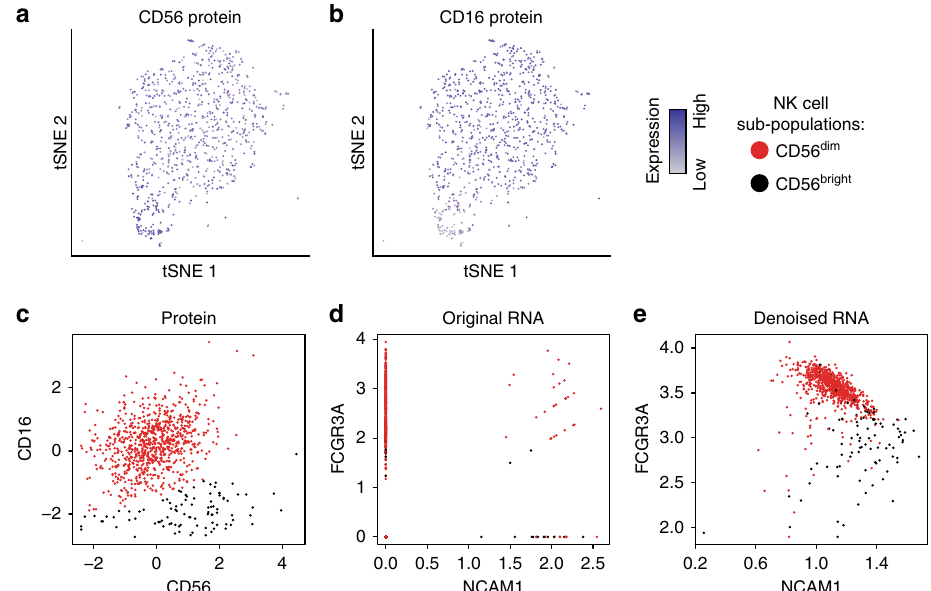
Fig. 8 Denoising enhances discovery of cellular phenotypes. tSNE visualization of transcriptomically derived NK cell cluster colored by CD56 ( a ) and CD16 ( b ) protein expression levels. Grey and blue indicate relative low and high expression, respectively. c shows CD56 and CD16 protein expression across NK cells, revealing two distinct sub-populations de fi ned as CD56dim (red) and CD56bright (bright). d , e depict expression of corresponding RNAs NCAM1 and FCGR3A using the original count data and DCA denoised data, respectively. Cells are colored by protein expression derived assignment to CD56bright (black) and CD56dim (red) NK cell sub-populations NATURE COMMUNICATIONS| (2019) 10:390